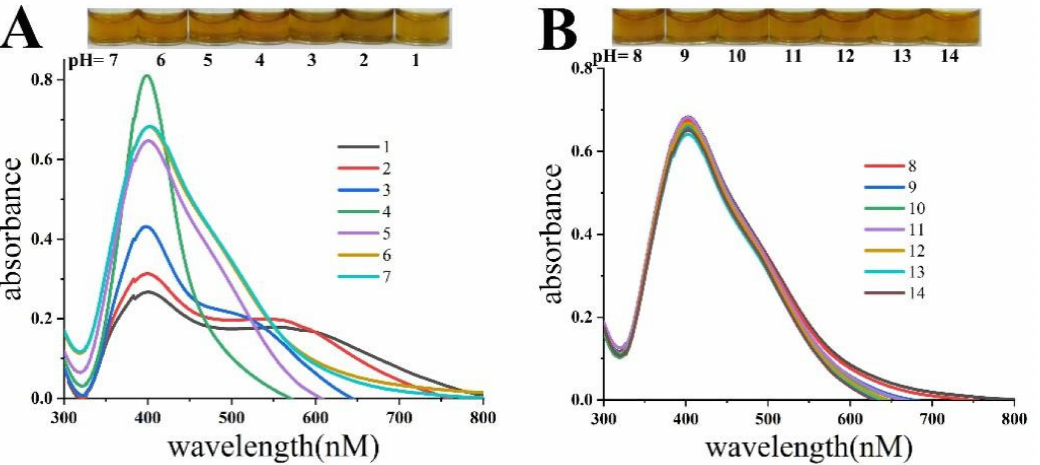
Figure 3. The photographs and UV spectra of HPS-AgNPs under ( A ) acidic and ( B ) basic